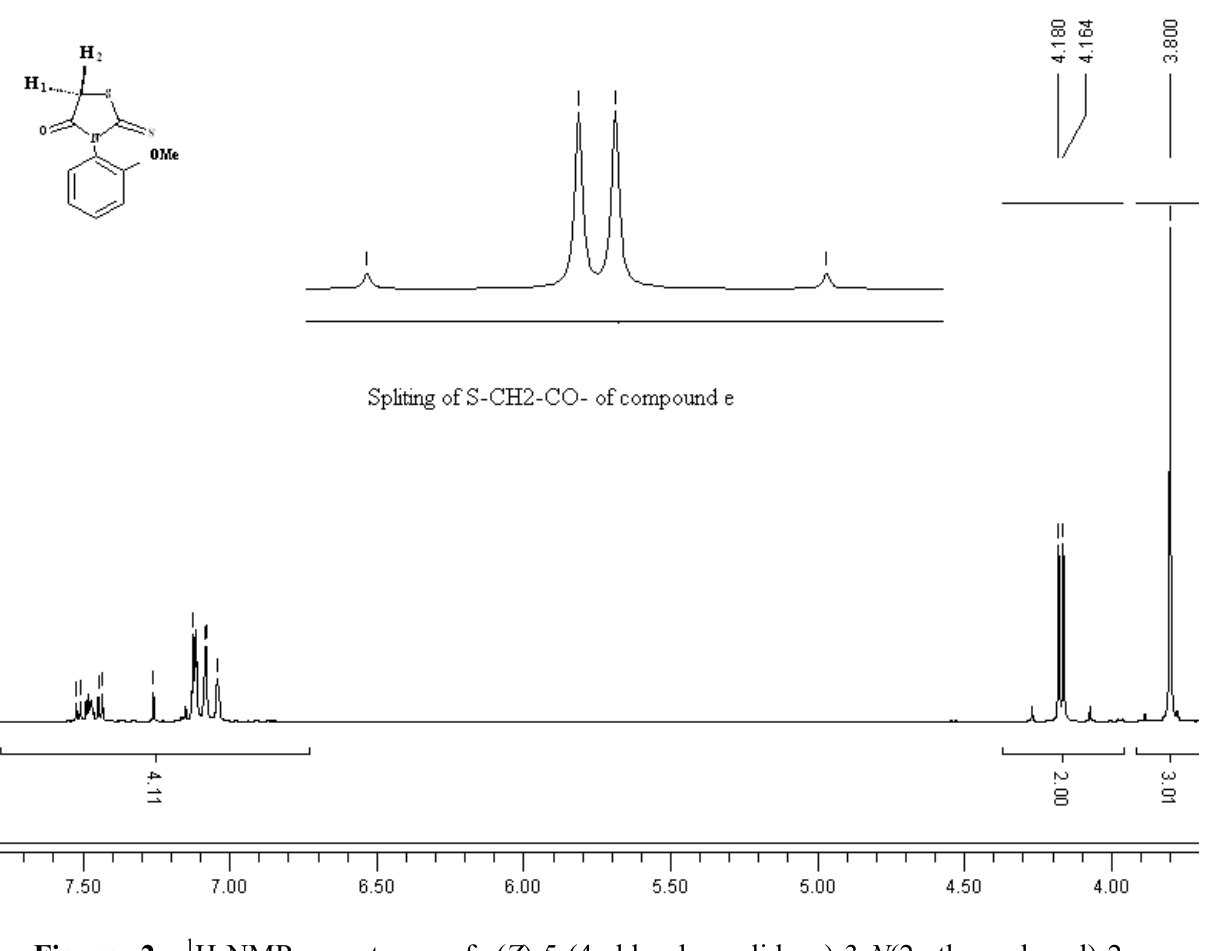
Figure 2. 1 H-NMR spectrum of ( Z )-5-(4-chlorobenzylidene)-3- N (2-ethoxyphenyl)-2- thioxothiazolidin-4-one ( 1g